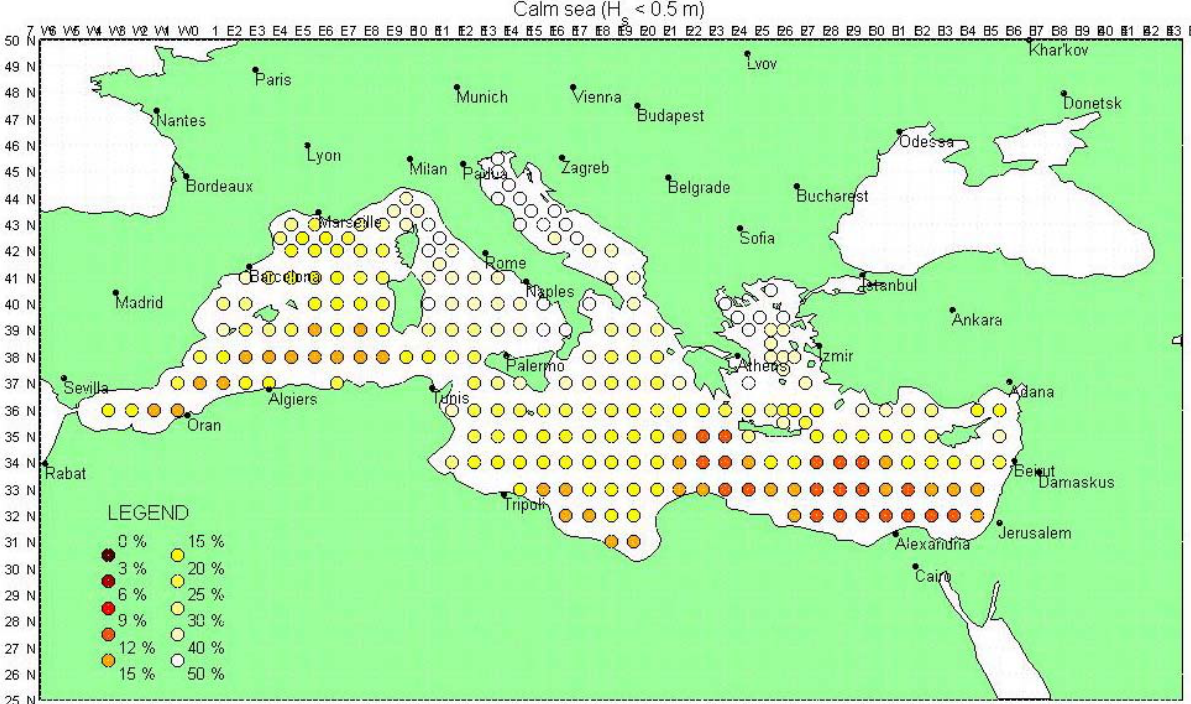
Figure 3. Percentage of calm sea